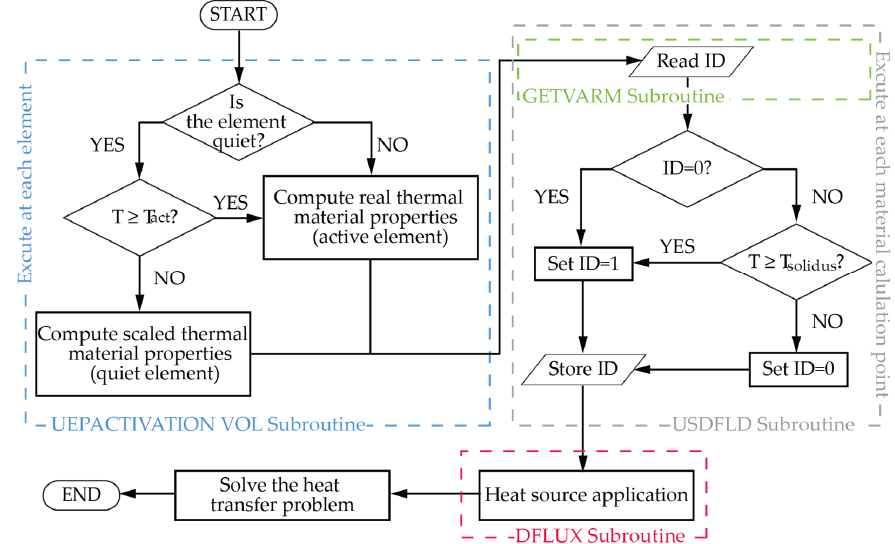
Figure 3. FE model structure and the subroutine for the material addition (UEPACATIVATION VOL), the material state variable for the melted material (USDFLD), and heat flux application (DFLUX) implementations.